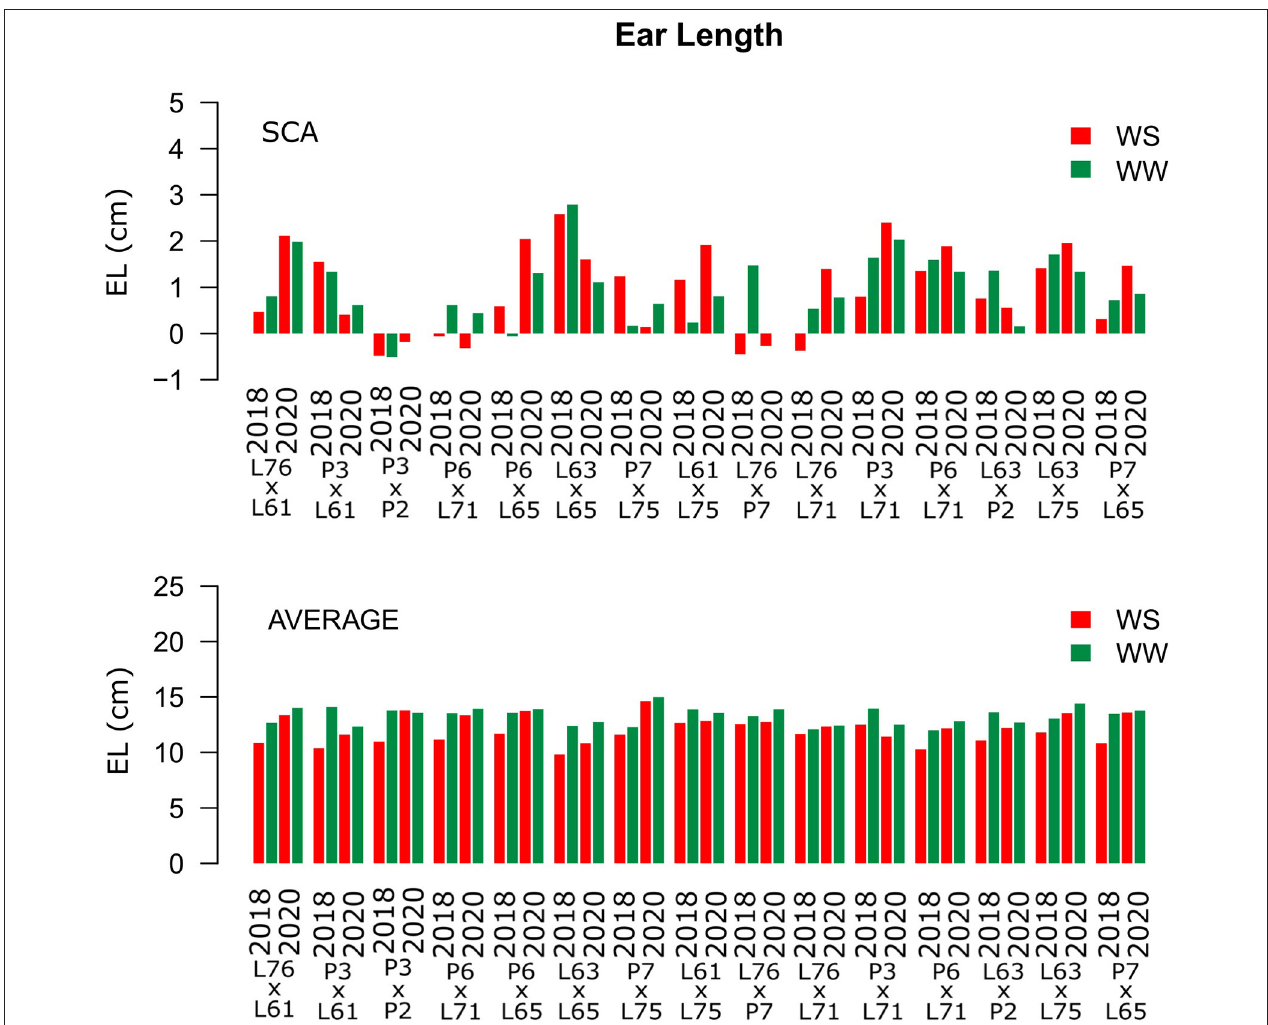
FIGURE 6 | Estimation of the SCA and EL (cm) mean values for popcorn hybrids evaluated under two WCs and crop seasons in 2018 and 2020. WS is represented by red bars and the WW condition represented by dark-green bars.